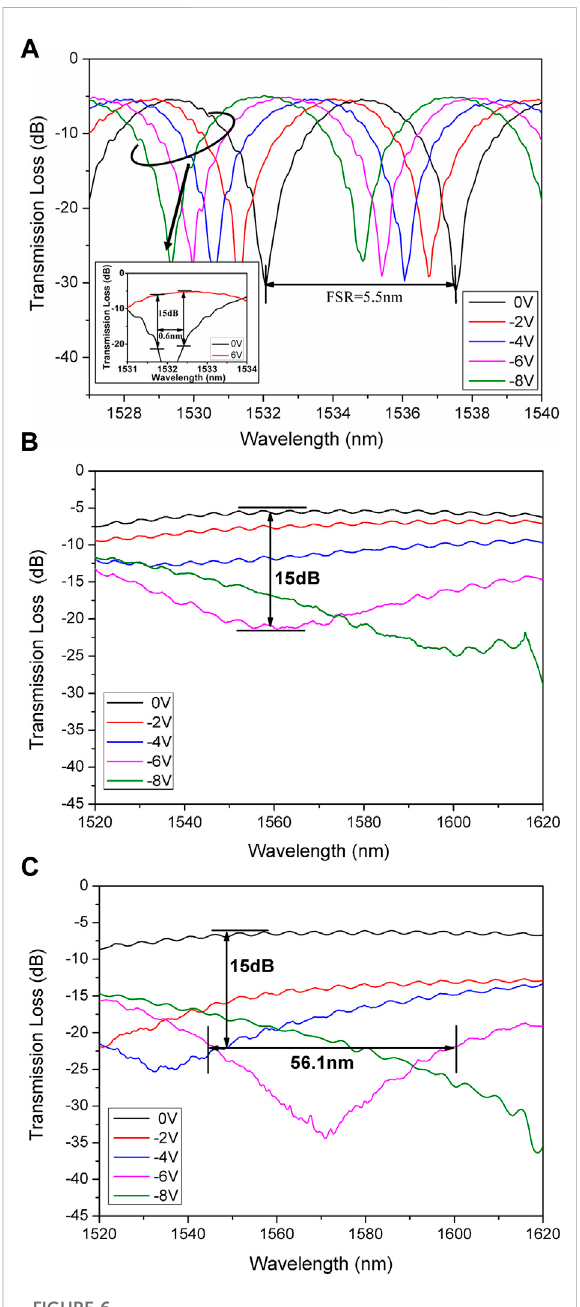
FIGURE 6 The transmission spectrum of (A) conventional asymmetric MZM, (B) conventional symmetric MZM and (C) light-intensity- balanced